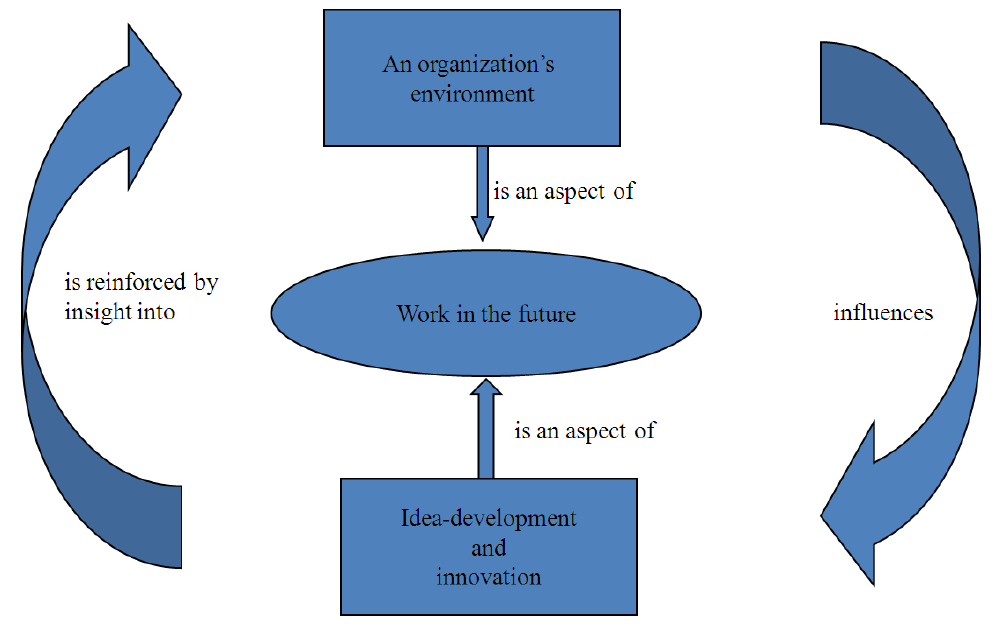
Fig. 1. Aspects of work in the